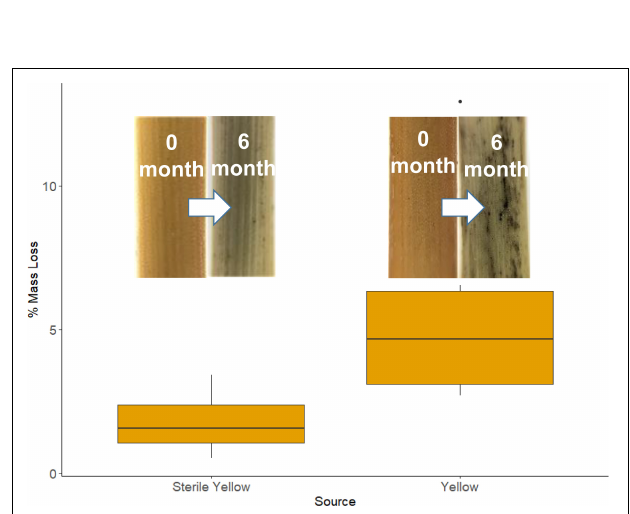
FIGURE 5 | Mean percent mass loss from recently senesced sterile and non-sterile yellow S. sabulicola tillers. Inserts are of lower portions of sterile yellow tillers at 0 and 6 months, and unsterilized yellow tillers at 0 and 6